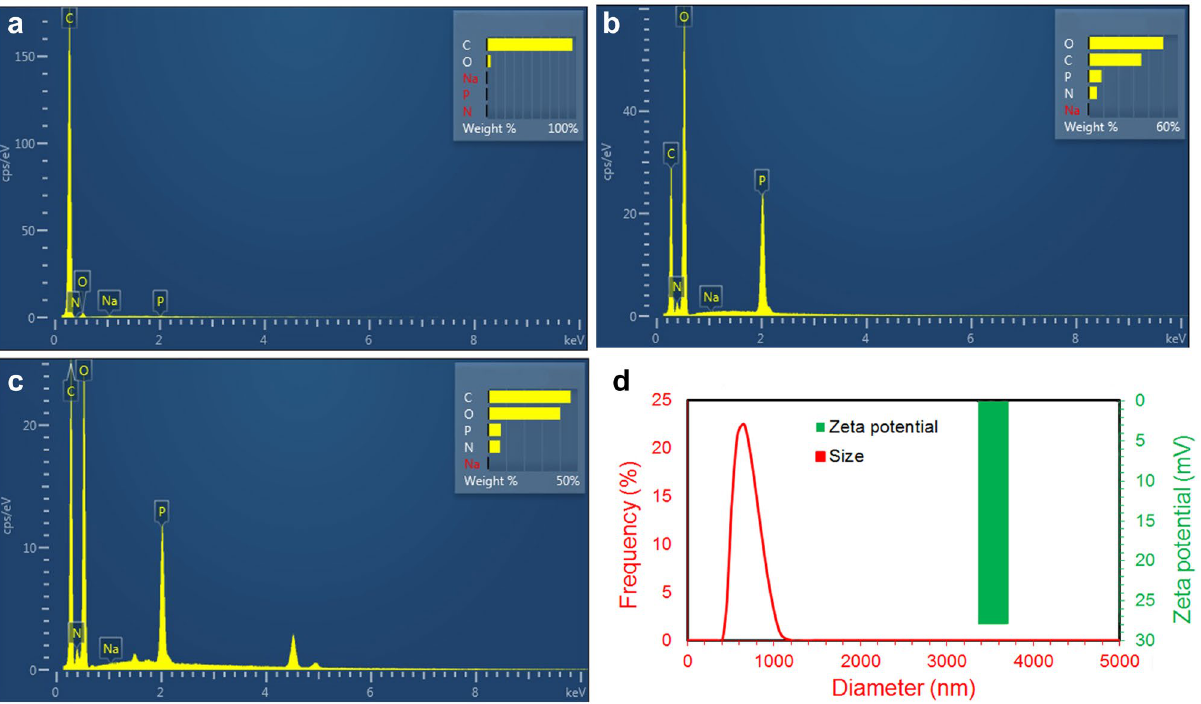
Figure 4. EDAX spectrum of ( a ) BSG nanosheets, ( b ) chitosan nanoparticles, ( c ) BSG/chitosan nanocomposites, and ( d ) the size distribution and zeta potential values of BSG/chitosan